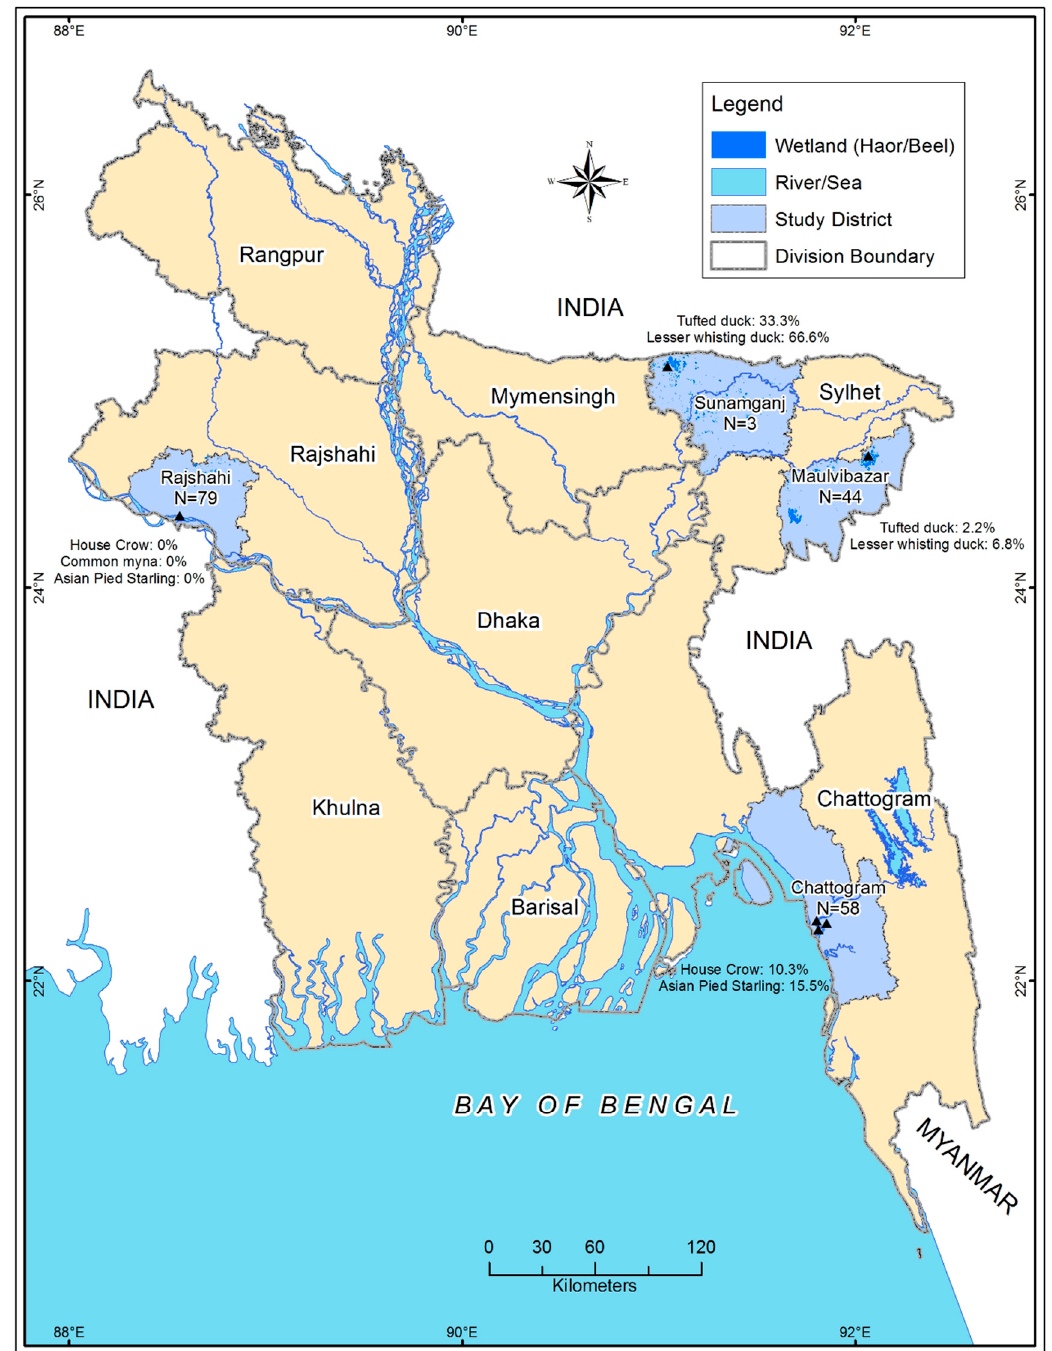
Figure 1. Map of Bangladesh. Sampling locations plotted using the spatial analyst tool of ArcGIS (ArcMap, version 10.2, Environmental Systems Research Institute, Redlands, CA, USA). Study sites for estimating seroprevalence of West Nile Virus in resident and migratory wild birds ( n = 184) with their sample size and % of positive species in four different locations of Bangladesh from December 2012 to February 2016.